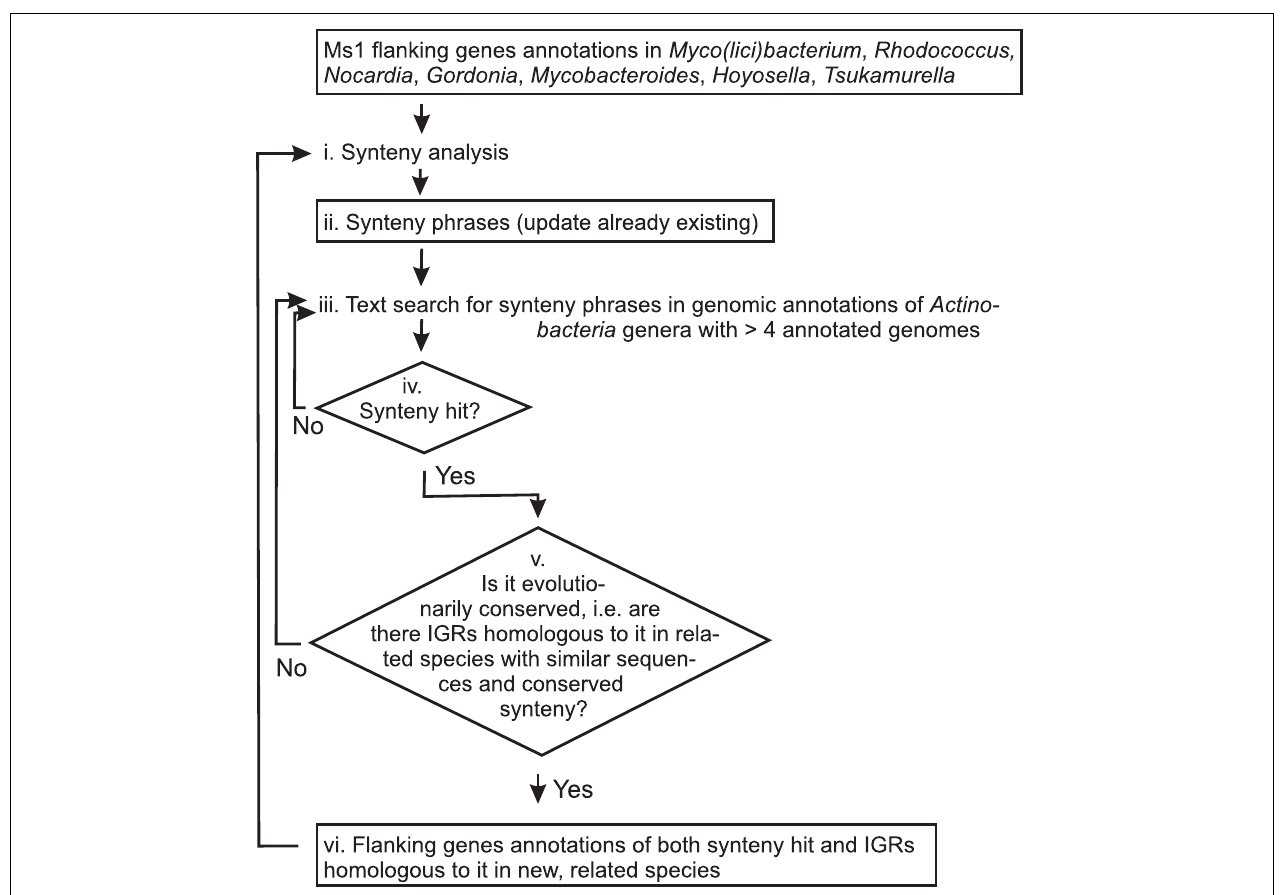
FIGURE 5 | Scheme of the linguistic gene synteny search for Ms1 RNA in Actinobacteria . Titles of analyzed data and information are in boxes, while analytic steps are shown as plain text. Arrows indicate the data and information flow. Synteny analysis (step i.) generates Synteny phrases ( Tables 1 – 3 , step ii.). For the first synteny analysis, annotations of Ms1 flanking genes from Mycobacterium, Rhodococcus, Nocardia , Gordonia, Mycobacteroides, Hoyosella, and Tsukamurella were used and Table 1 generated. Synteny phrases are used to search for new putative Ms1 candidates (iv. Synteny hits). If the putative Ms1 candidates are evolutionary conserved in related species (step v.), annotations of their flanking genes (step vi.) are added to the Synteny analysis (step i.) to generate updated Synteny phrases (step ii., Tables 2 , 3 ) and the whole procedure is